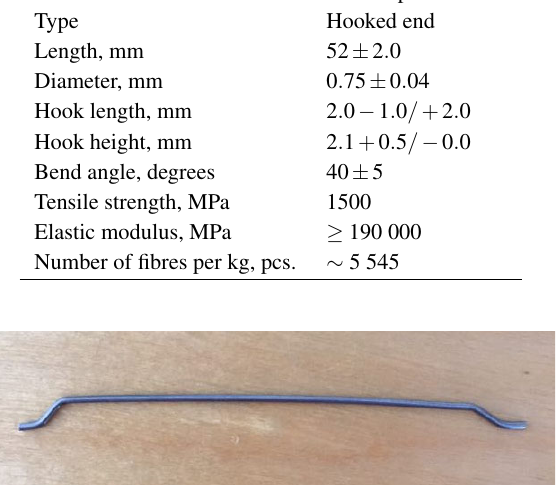
Fig. 1. Photo of a